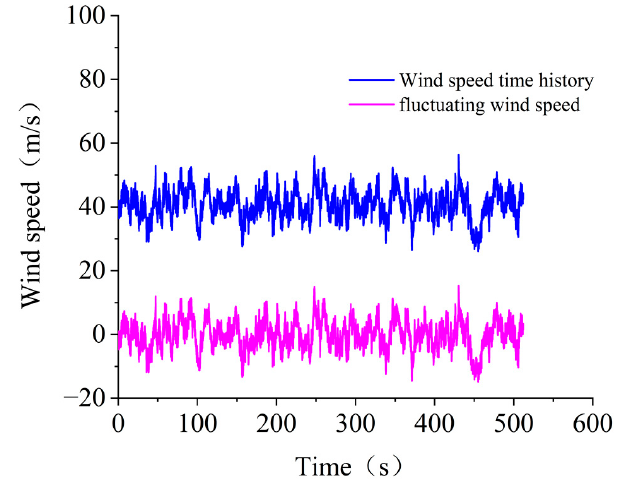
Figure 5. Wind spectrum comparison.